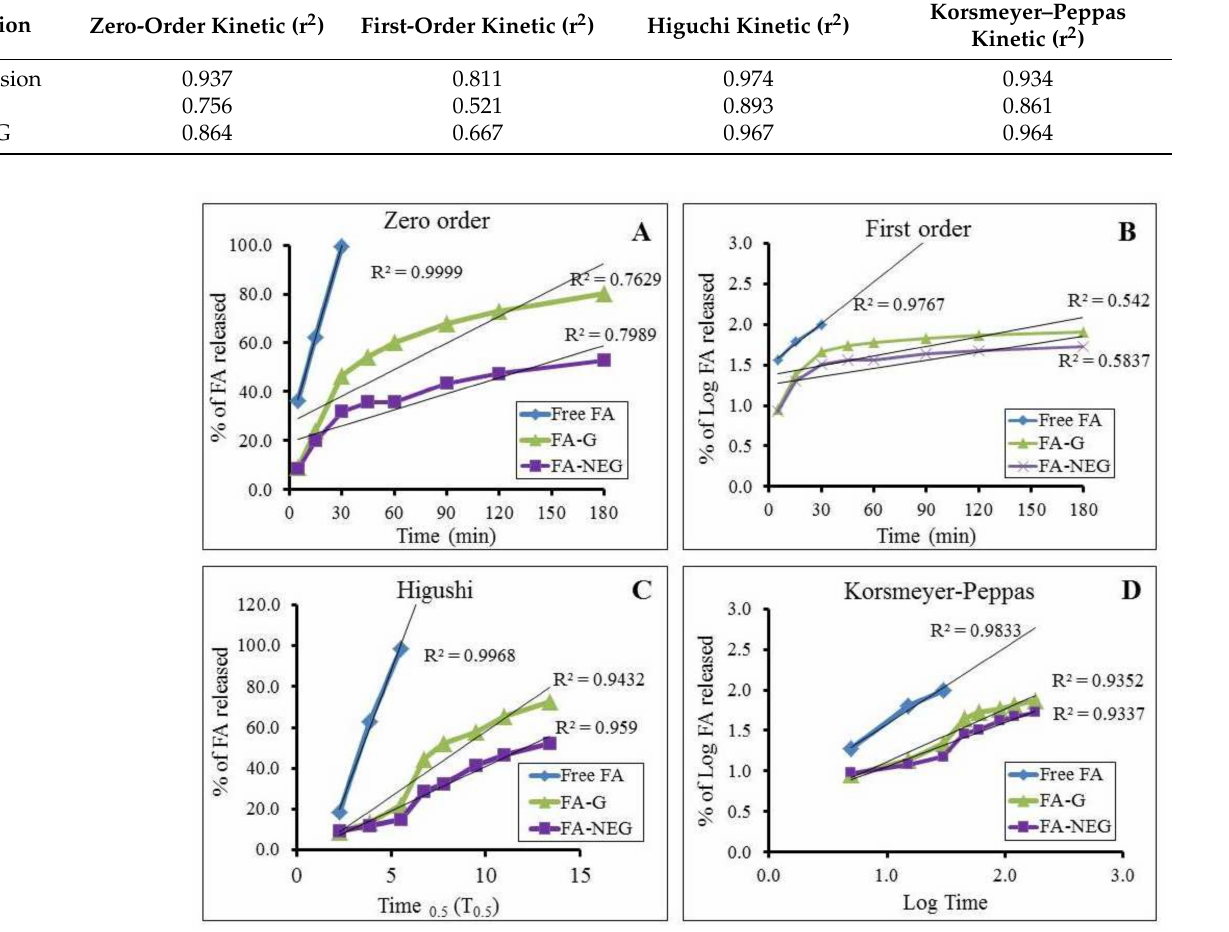
Figure 10. Percentage of drug released from developed FA formulations against free FA, and their kinetic analysis, according to ( A ) zero-order ( B ) first-order, ( C ) Higuchi, and ( D ) Korsmeyer–Peppas